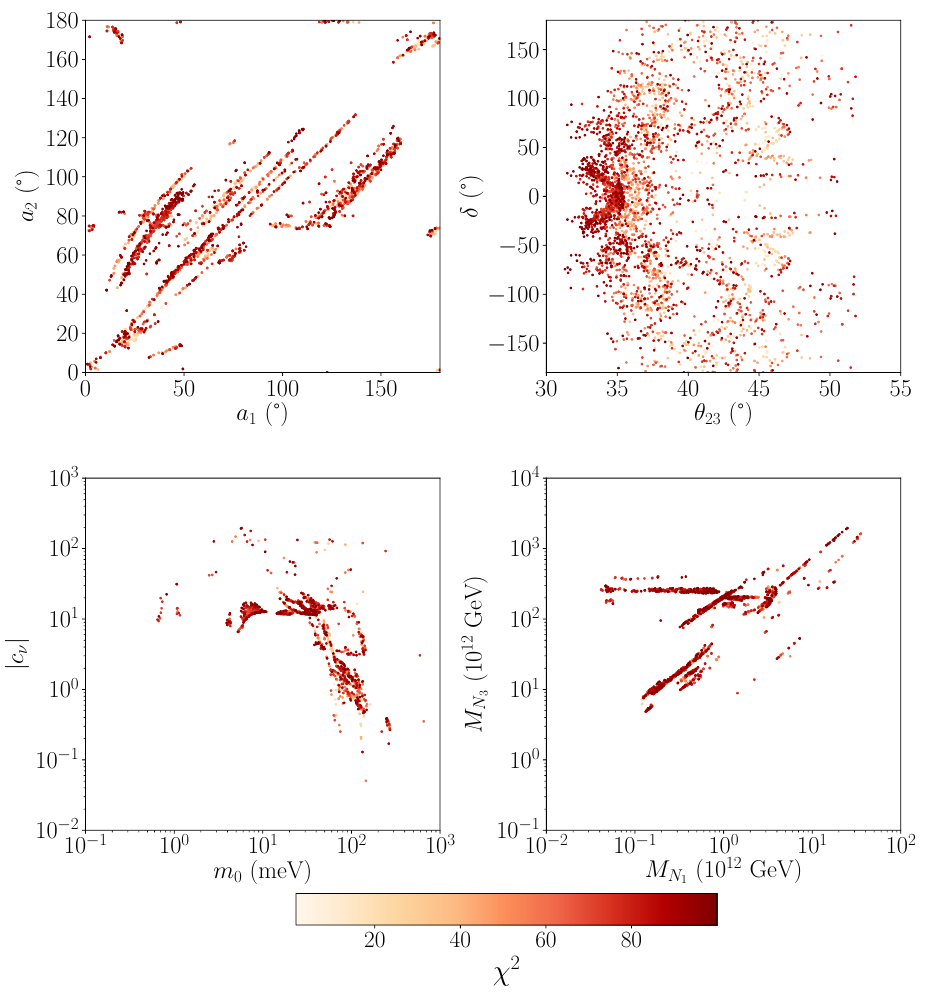
Figure 3 . Two-dimensional correlations between theory inputs (left two panels) and predicted observables (right two panels) for χ 2 < 100 for θ not